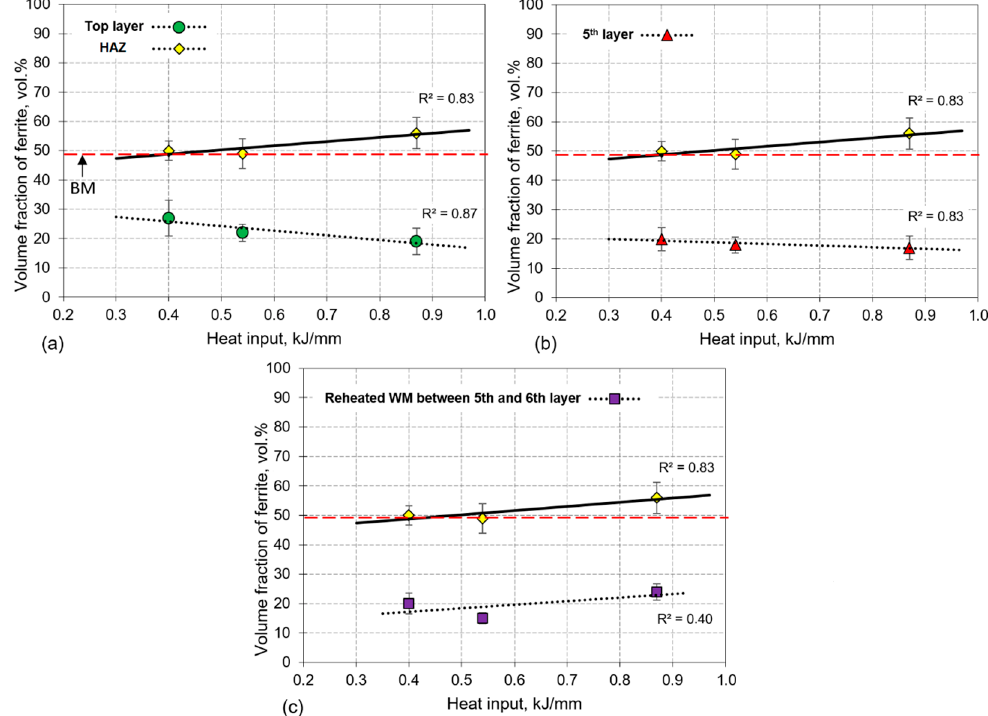
Figure 12. Effect of heat input on volume fraction of ferrite in different areas of deposited walls: ( a ) WM of top layer, ( b ) WM between 5th and 6th layer, ( c ) WM of 5th layer. The dashed red lines represent volume fraction of ferrite in the BM (48 vol.%).